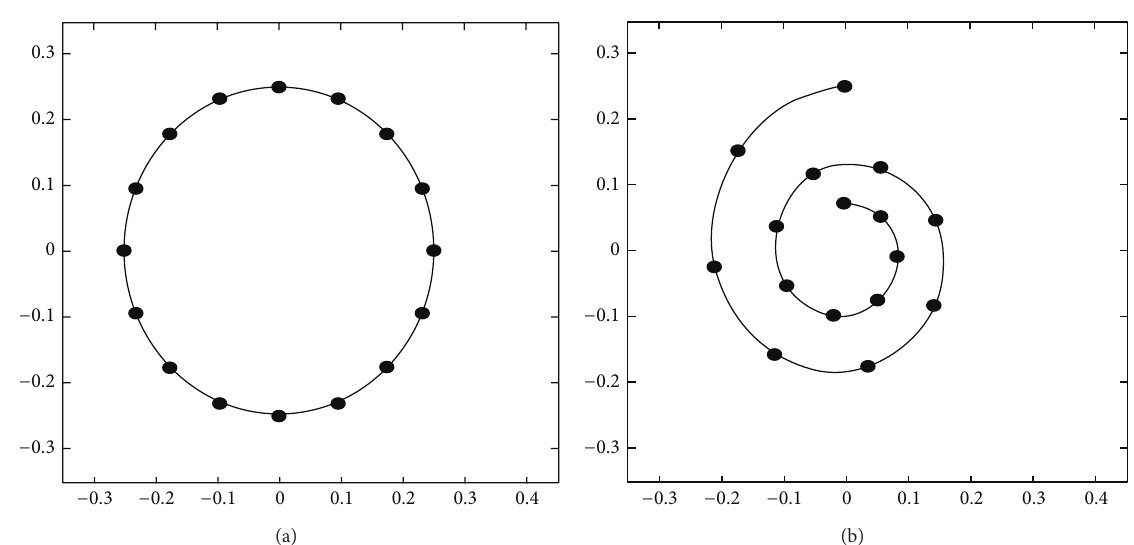
Figure 7: Circumference (a) and spiral (b) with 16 dipoles and 0.25 𝑑